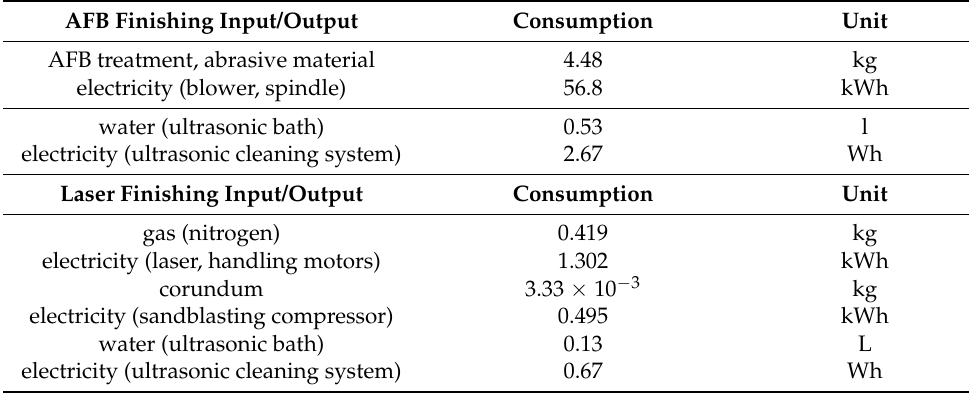
Table 3. Input/output consumption of the analyzed finishing processes.